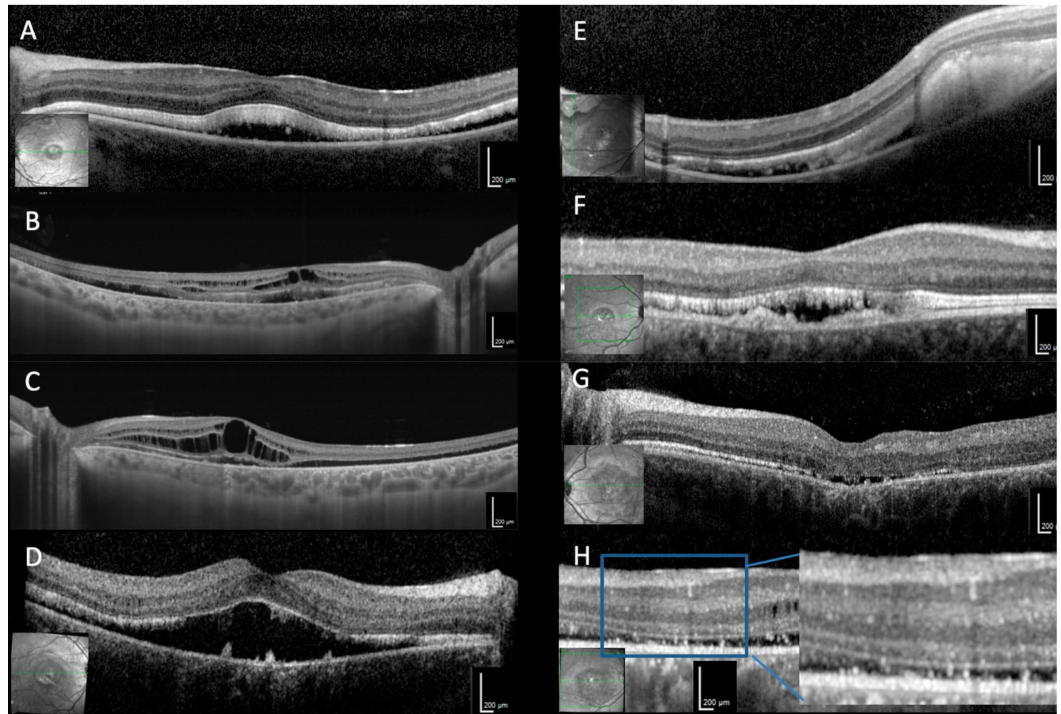
Figure 3. OCT findings. ( A ) Highly reflective material (most likely elongated photoreceptor outer segments) adjacent to the detached retina (#1). ( B ) Moderate (#9, RE) and ( C ) severe (#9, LE) intraretinal cystoid spaces. ( D ) Serous retinal detachment involving the fovea with additional subretinal material adjacent to the RPE presented as bumps (#2). ( E ) The subretinal material was mostly continuous (#7), ( F ) but could also appear as separate stalactites and stalagmites (#12) ( G ) Reduced thickness of the inner retinal layers, temporally the ellipsoid zone is also disintegrated (#2) ( H ) Hyperreflective foci